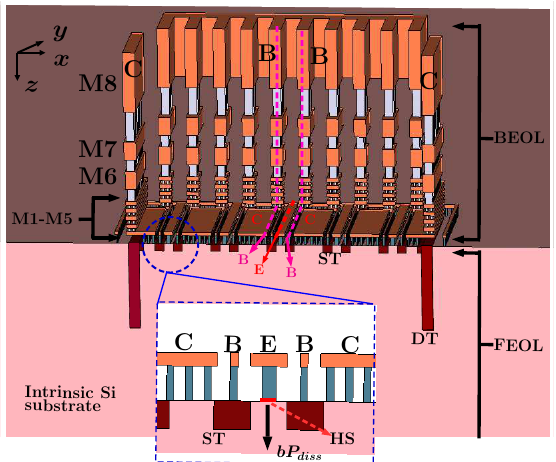
Figure 1. 3D cross-sectional view of a five-finger TCAD structure of STMicroelectronics B55 process [13] containing shallow and deep trenches along with the eight metal layers (M1 to M8). A closer view of the corner finger is shown at the inset with emitter (E), base (B), and collector (C) contacts, and the heat source